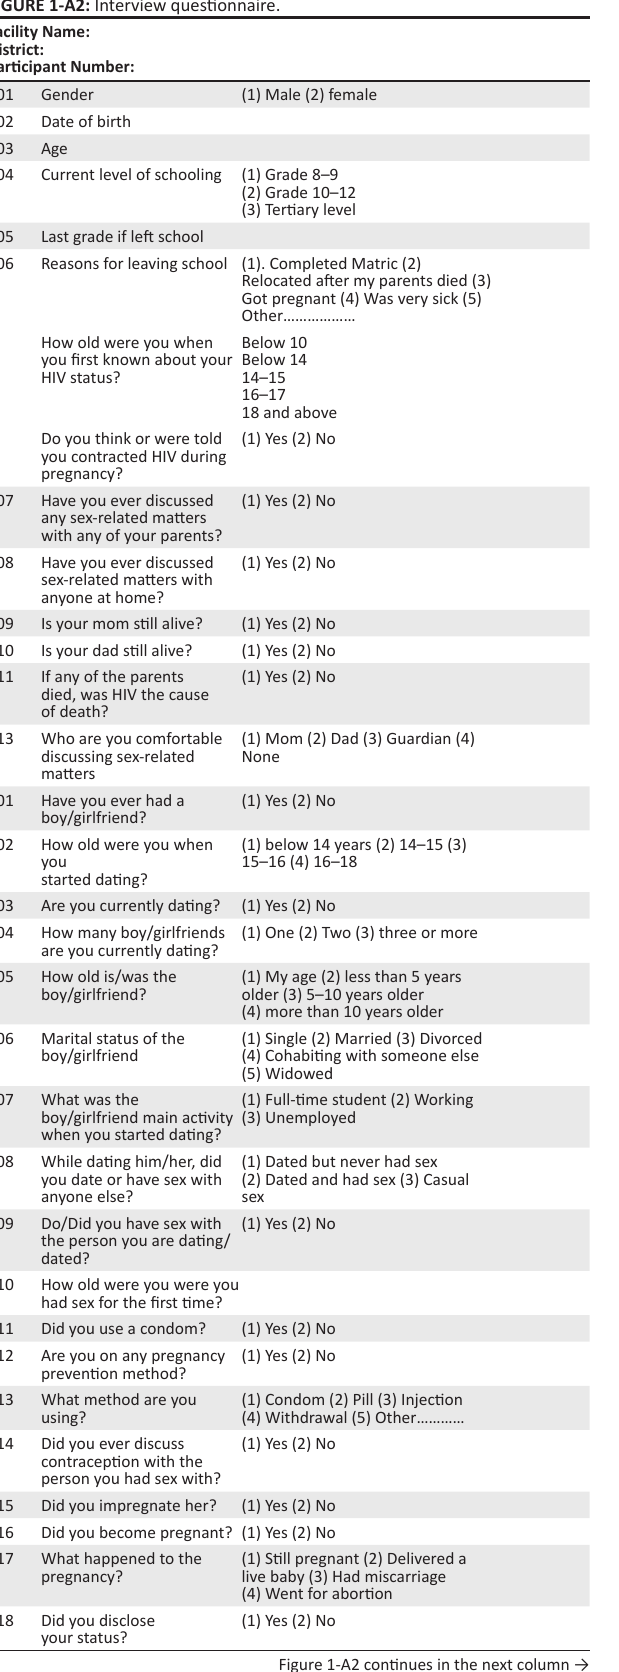
Figure 1-A2 continues in the next column